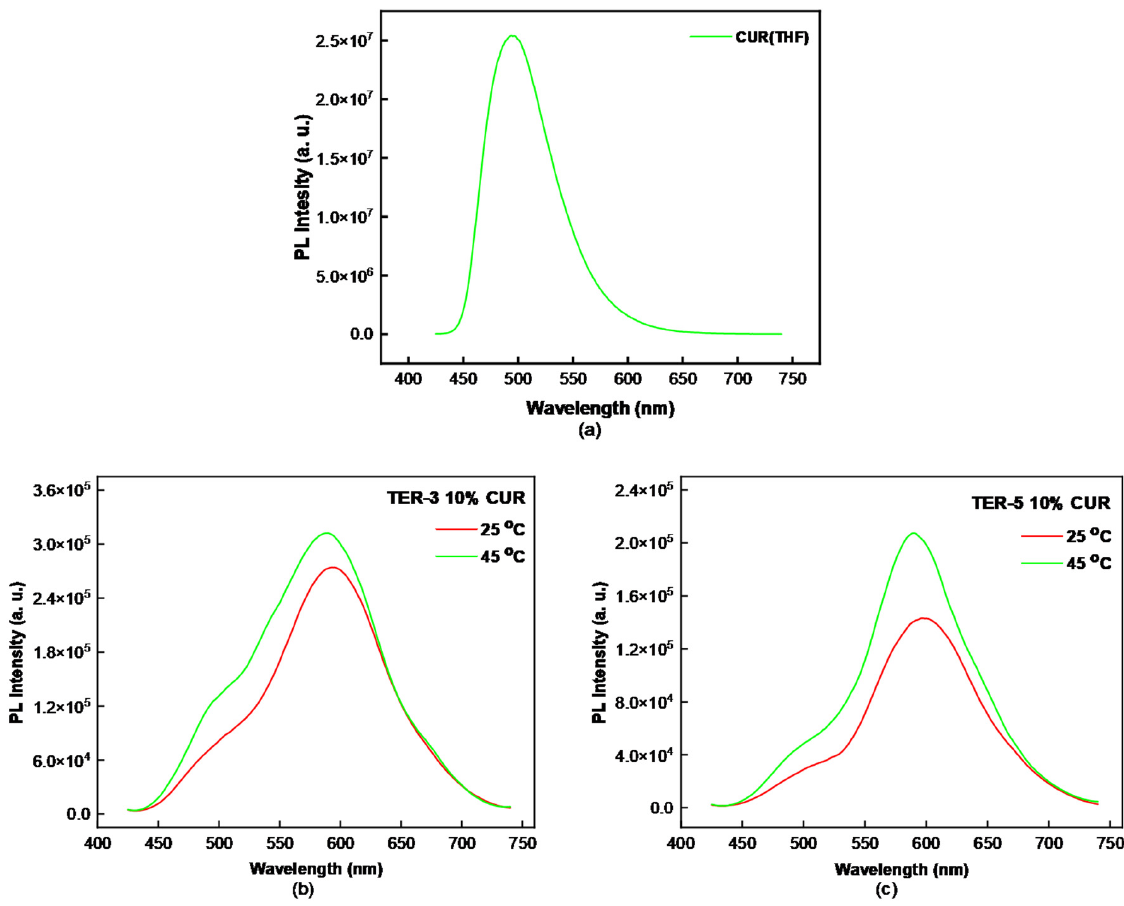
Figure 12. ( a ) Fluorescence of curcumin in THF ( b ) TER-3/CUR ( c ) TER-5/CUR mixed aggregates fluorescence signal as a function of temperature.